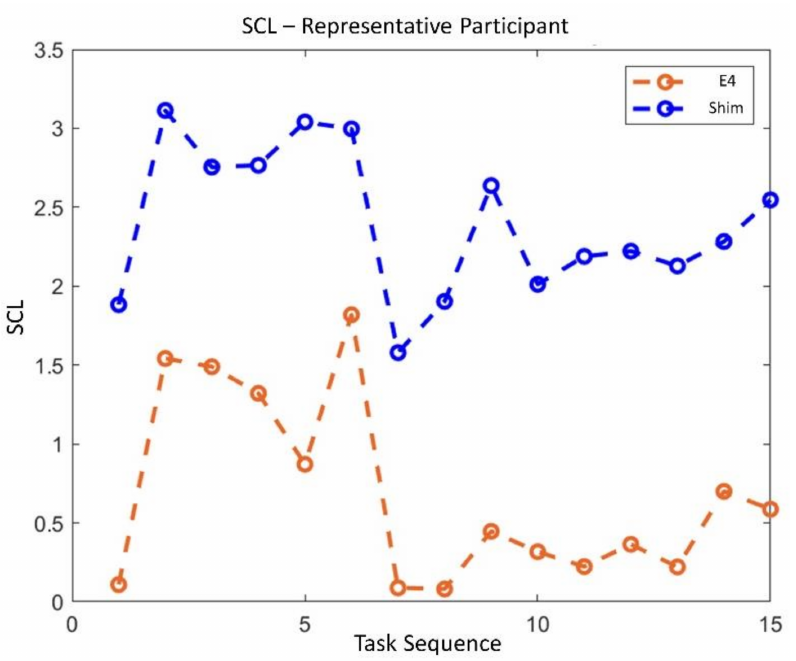
Figure 11. Time dynamics of SCL across all experimental task and conditions for both consumer wearable (red) and laboratory device (blue).